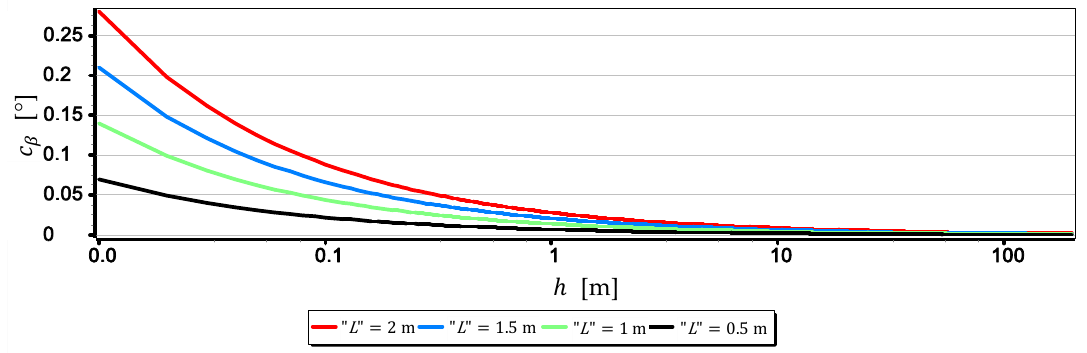
Figure 14. Measurement resolution of the horizon slop 𝑐 𝛽 as a function of ℎ a.s.l. for chosen wave heights "𝐿" ( 𝐹𝑂𝑉 𝐻 = 63.27° – DJI FC220).